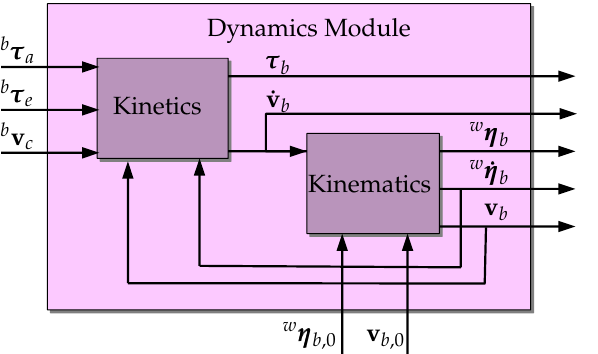
Figure 3. Logic representation of both Kinetics and Kinematics inside the Dynamics Model. Inputs and outputs are also represented.